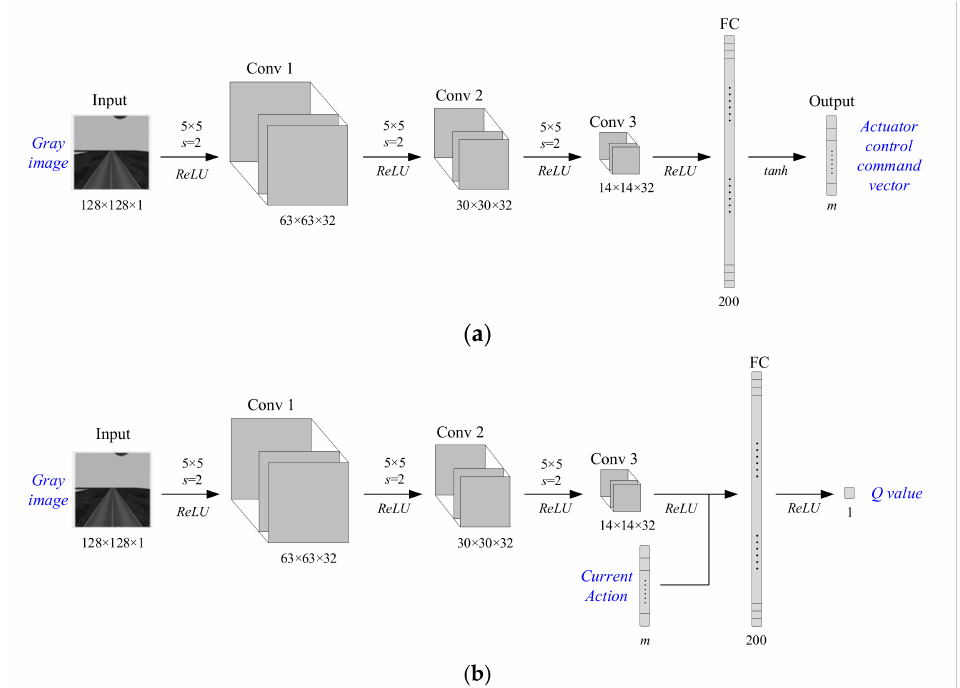
Figure 4. The network architectures: ( a ) the architecture of the actor-network; ( b ) the architecture of the